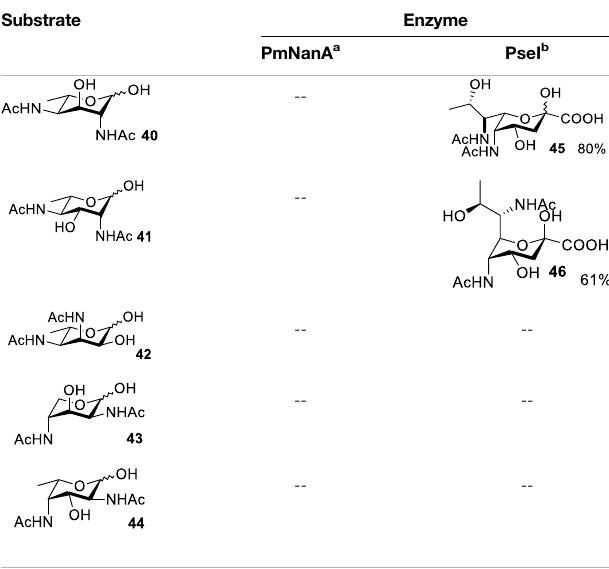
TABLE 2 | Reactions catalyzed by pseudaminic acid synthase (PseI) and sialic acid synthase (PmNanA).